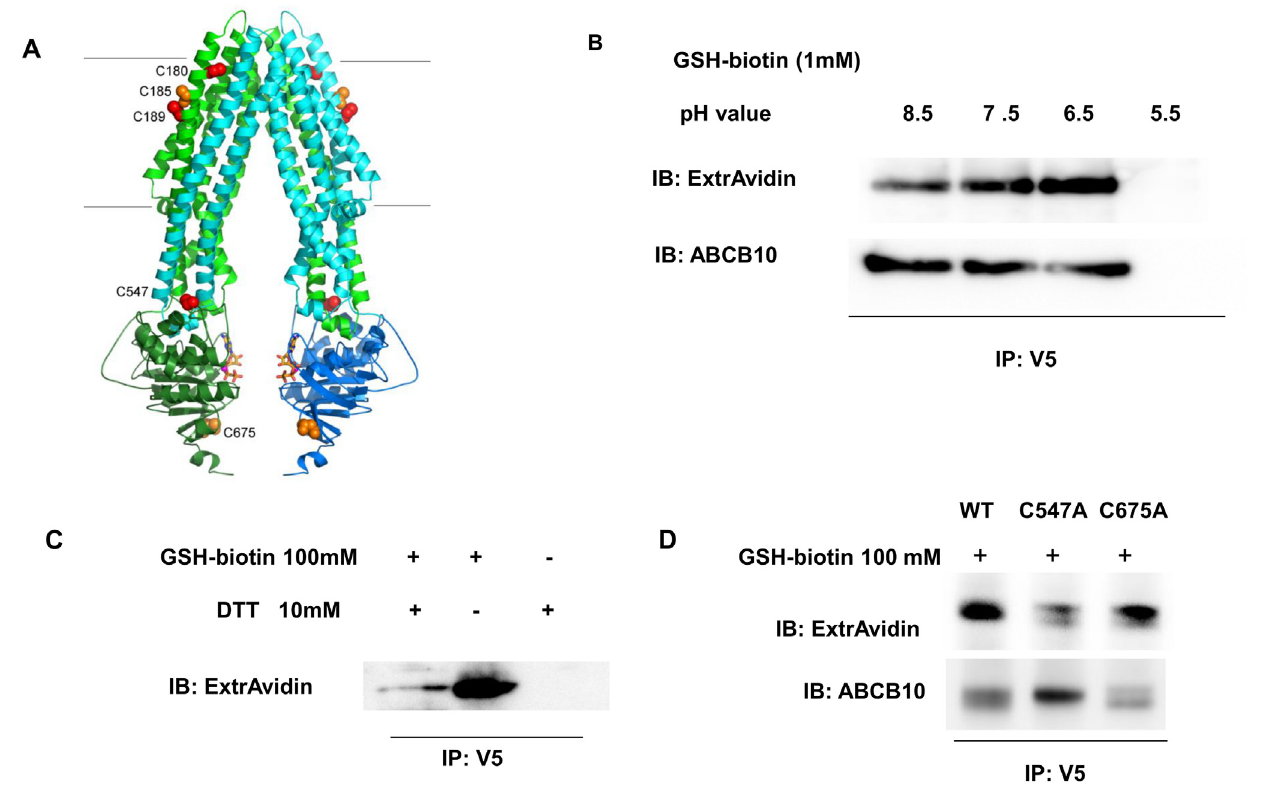
protein from mouse to human: Cys215 (human) aligns with Cys180 (mouse); Cys 224 (human) aligns with Cys189 (mouse) and Cys582 (human) aligns with Cys547 (mouse). These conserved residues are shown in red in the human ABCB10 structure (Fig 7). The mouse se- quence has two additional cysteines in the folded protein (Cys185 and Cys675), which align with human Ala220 and Thr710 and are represented in orange (Fig 7). For mitochondrial ma-